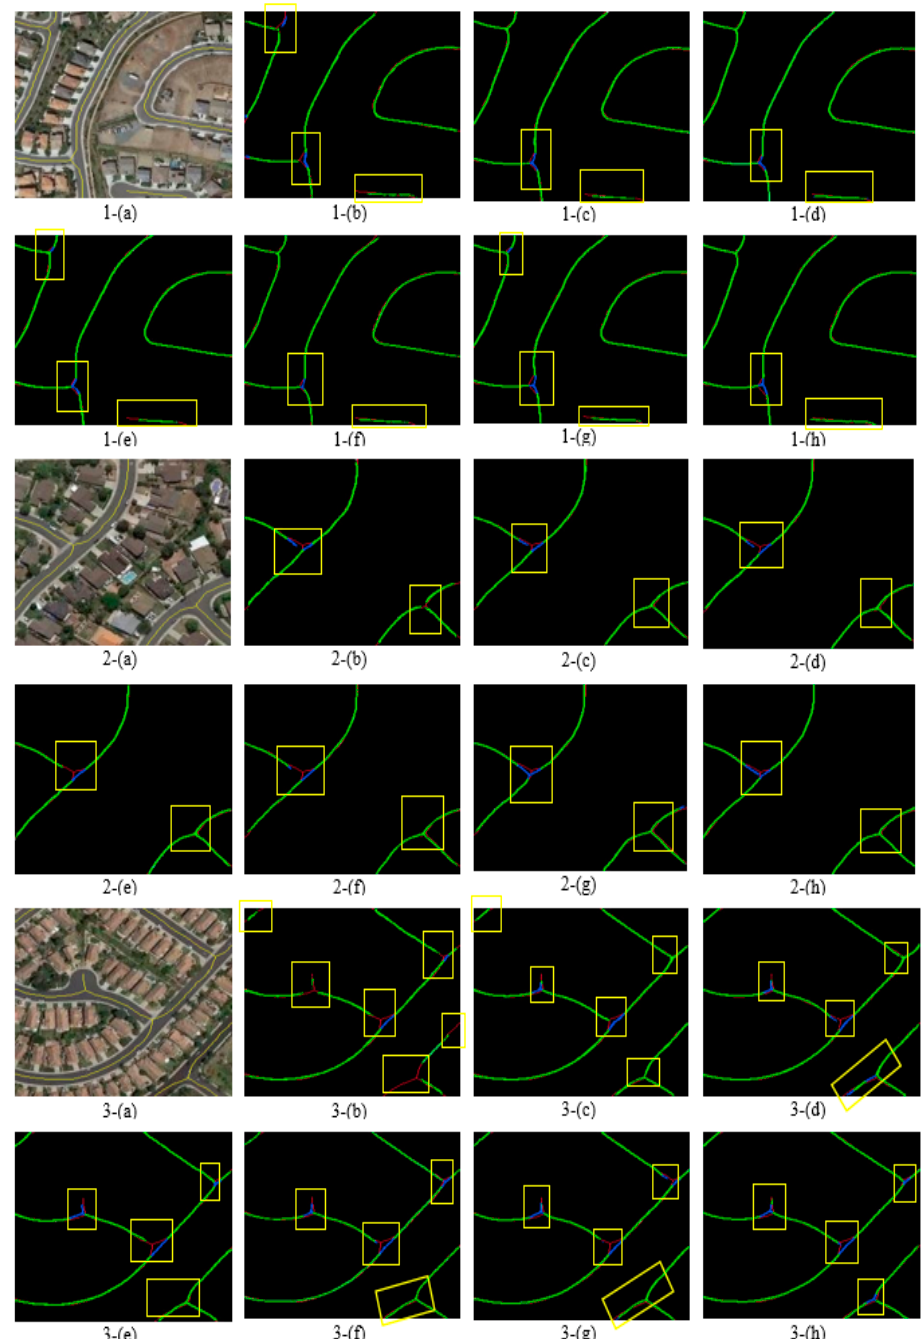
Figure 4. Visual comparison for centerline extraction by ( a ) original image with the corresponding ground truth, ( b ) cascaded net, ( c ) RCNN2, ( d ) RCNN3, ( e ) proposed model in Figure 2A, ( f ) proposed model in Figure 2B, ( g ) proposed model in Figure 2C, and ( h ) proposed model in Figure 2D. Green, red, and blue represent TP, FN, and FP, respectively.